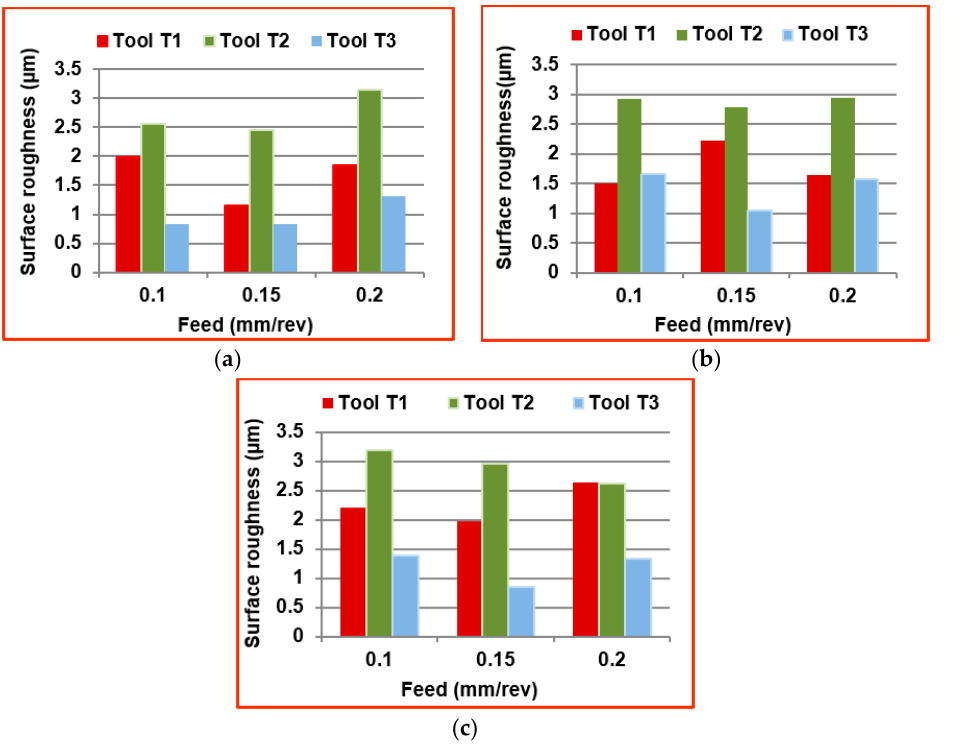
Figure 6. Comparison of surface roughness at different machining conditions with ( a ) 3000 rpm; ( b ) 6000 rpm; ( c ) 9000 rpm.